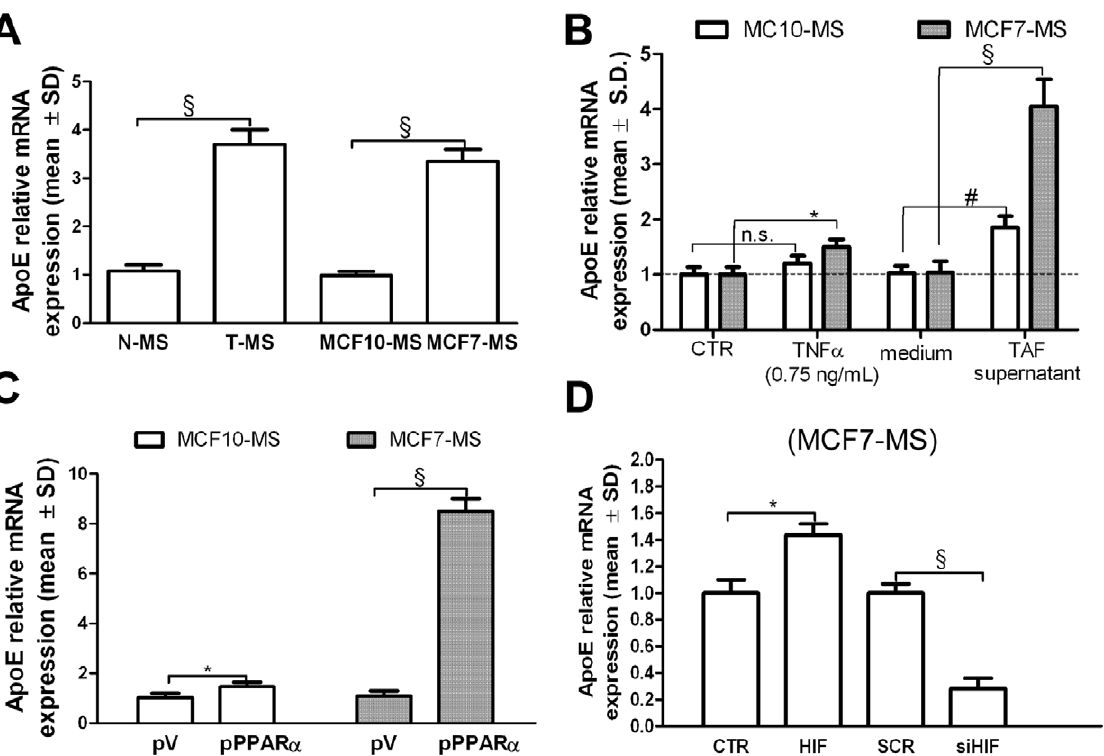
Figure 7. ApoE is under the control the PPAR a /HIF1 a interplay in breast CSCs. (A) ApoE mRNA qPCR analysis in N 2 /T-MS (samples 1–5) and in MCF10/MCF7-MS. (B) ApoE mRNA qPCR analysis in TAF supernantants (10%, 24 h), TNF a (0.75 ng/mL, 24 h)-exposed MCF7-MS. ApoE mRNA qPCR analysis in (C) pV/pPPAR a (48 h)-transfected MCF7-MS and MCF10-MS, and in (D) HIF1 vector (48 h) or SCR/siHIF1 (72 h)-transfected MCF7-MS. Data are expressed as mean 6 S.D., n=3, * p , 0.05, # p , 0.01, 1 p , 0.005, ANOVA test. n.s.: not